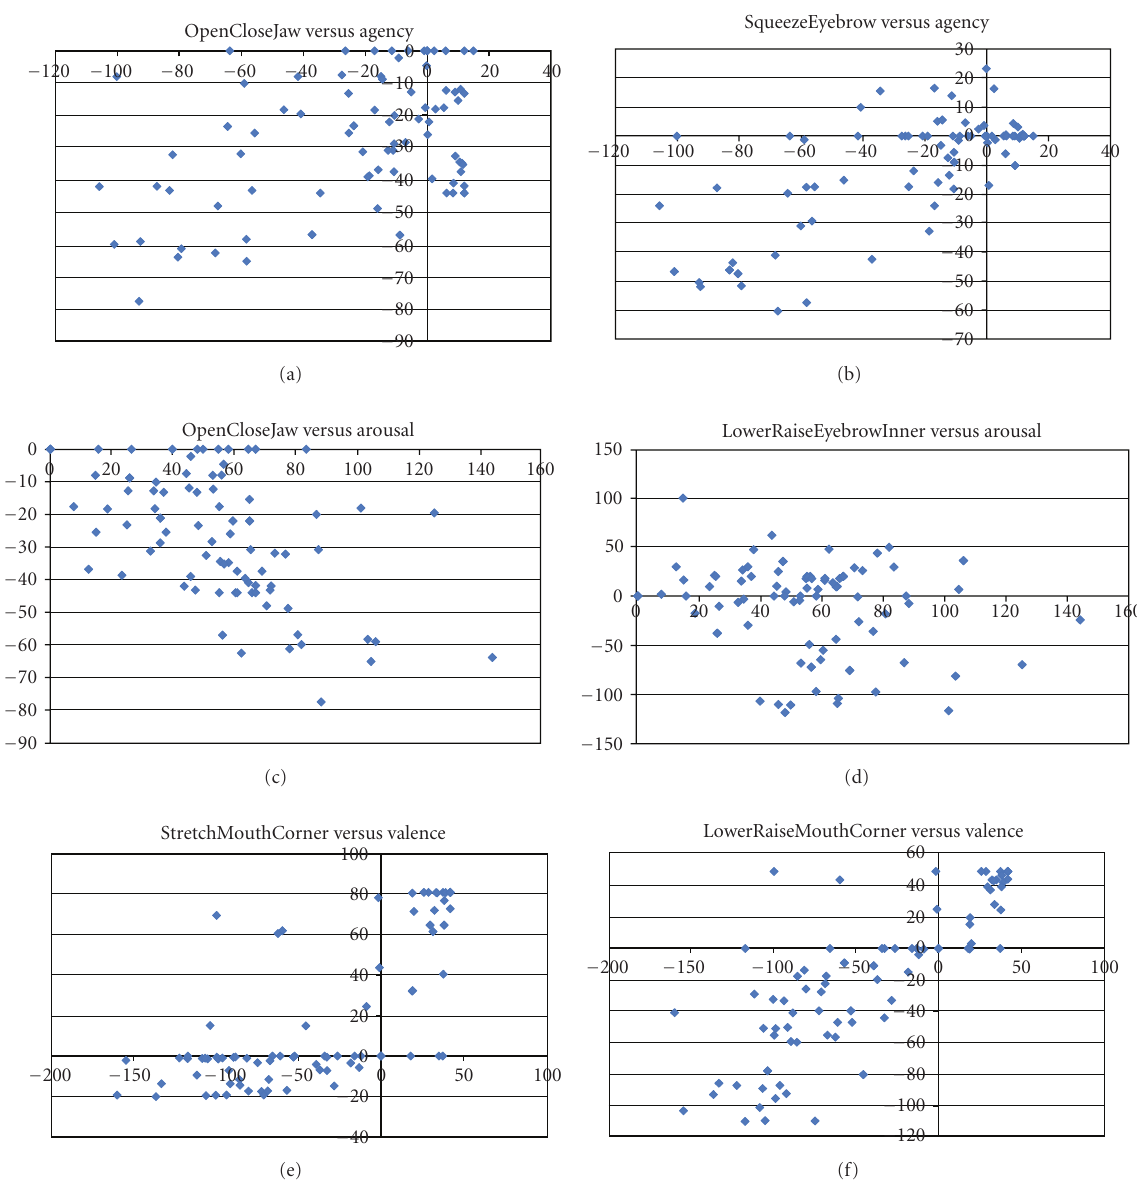
Figure 6: Example of distribution of facial action ( Y -axis) along dimensions ( X -axis). The data ranges are di ff erent as they are set based on available data. For example, in (a) the Open-Jaw case positive values correspond to closing of the jaw. Since the neutral face already has the mouth closed, no expression has used a positive value for this